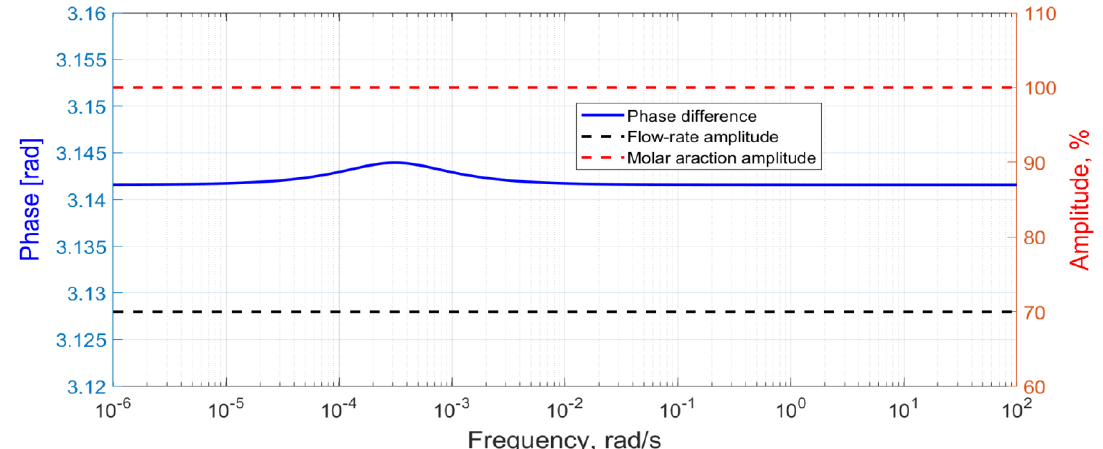
Figure 7. Optimised values of the phase shift and the input amplitudes as a function of forcing frequency for Case 5 around point SS5.